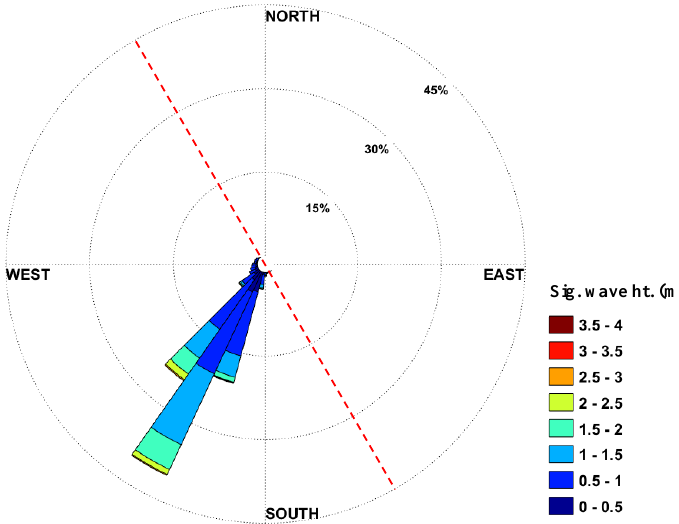
Figure 4. Wave rose diagram for the years 1988 to 2014 at 92° E and 21.25° N retrieved from ECMWF ERA-Interim data. The red dashed line indicates the coastline alignment.